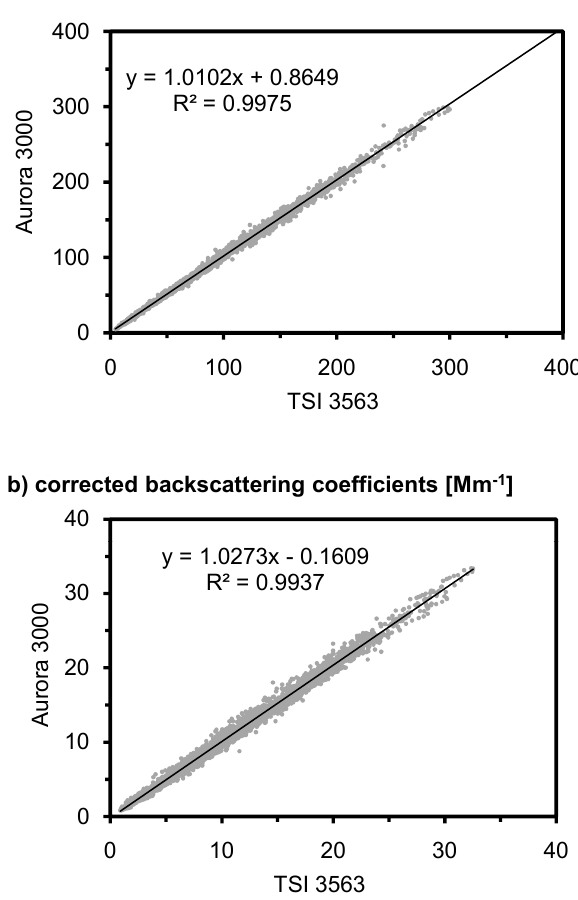
Fig. 8. Results from experiments with ambient air. Panel (a) Cor- relation between total scattering coefficients measured with the TSI model 3563 and Aurora 3000, respectively. Panel (b) shows the correlation for backscattering coefficients. Total scattering and backscattering at 525nm were corrected for angular sensitiv- ities. TSI 3525 scattering coefficients ware adjusted to wavelength 525nm using an interpolation based on the ˚Angstr¨om